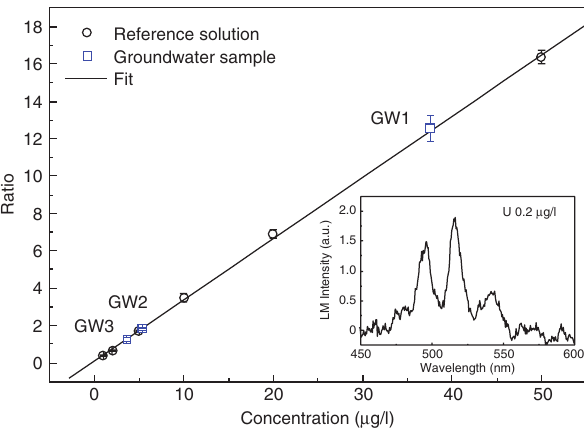
Figure 8 Solid line represents the calibration curve obtained by plotting the ratio of the luminescence intensity of U(VI) at 493.1 nm for reference solutions to the Raman intensity of water at 297 nm as a function of the uranium concentration. Squares represent the determined uranium concentrations in the groundwater samples, and the concentration values are listed in Table 2 (column 3). Inset shows the luminescence spectrum for a U(VI) reference solution of 0.2 μ g/l.